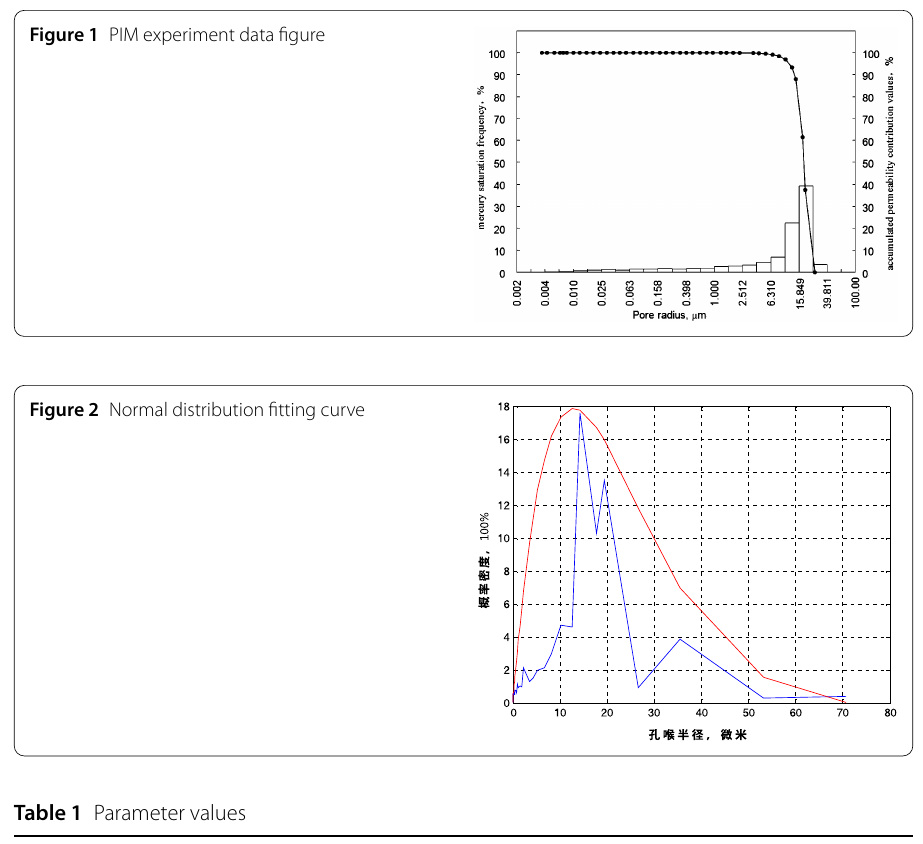
Figure 1 PIM experiment data figure